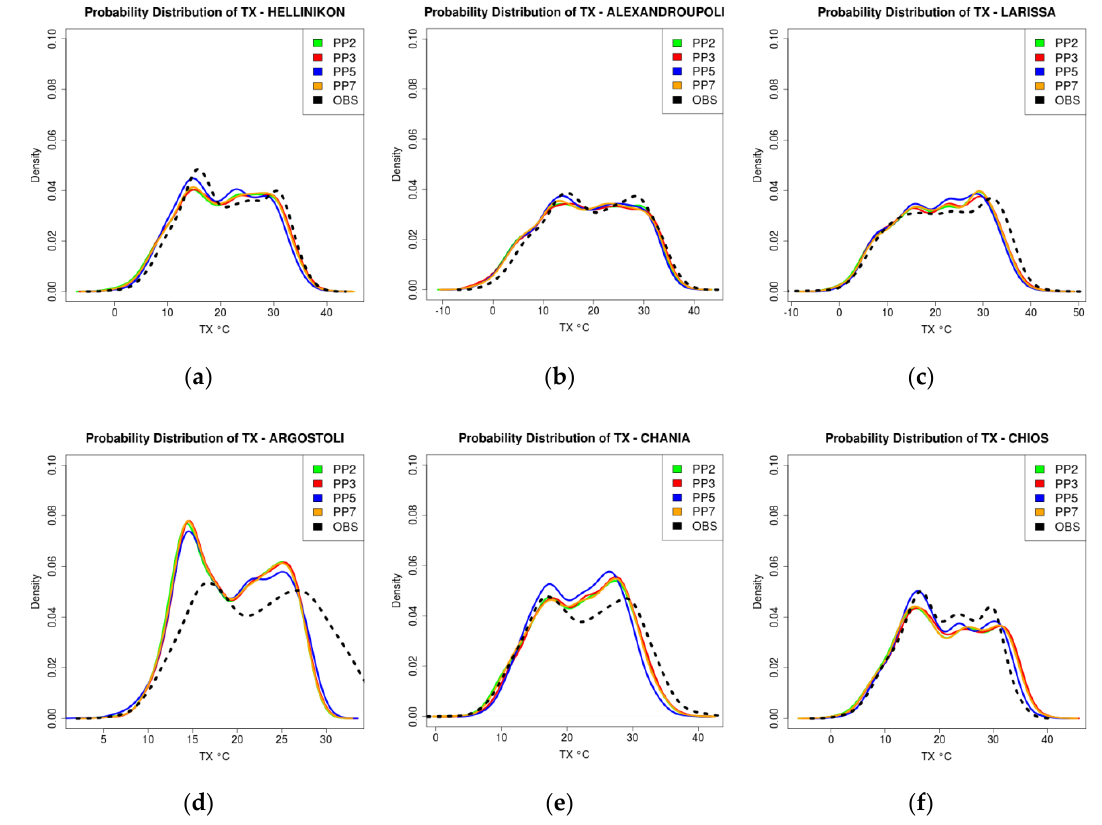
Figure 8. Comparison of the observed maximum temperatures by indicative weather stations, and the four simulated results in terms of probability distributions. The dashed line indicates the probability distribution of the